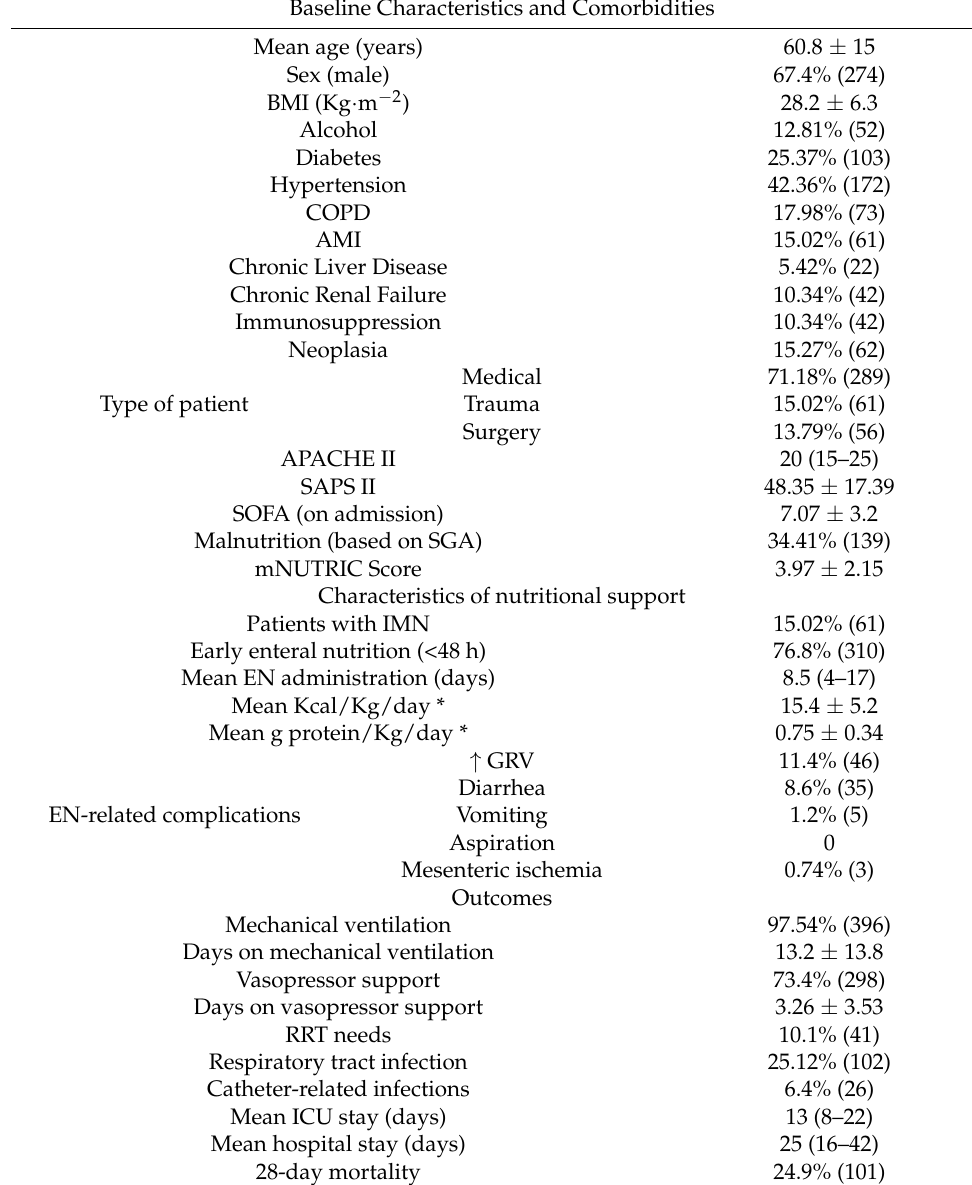
Table 1. Characteristics, nutritional therapy, and outcomes of patients receiving enteral